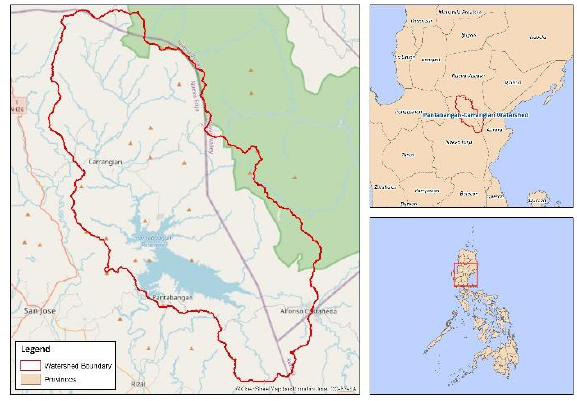
Figure 1. Location of the Study Area. Base map: